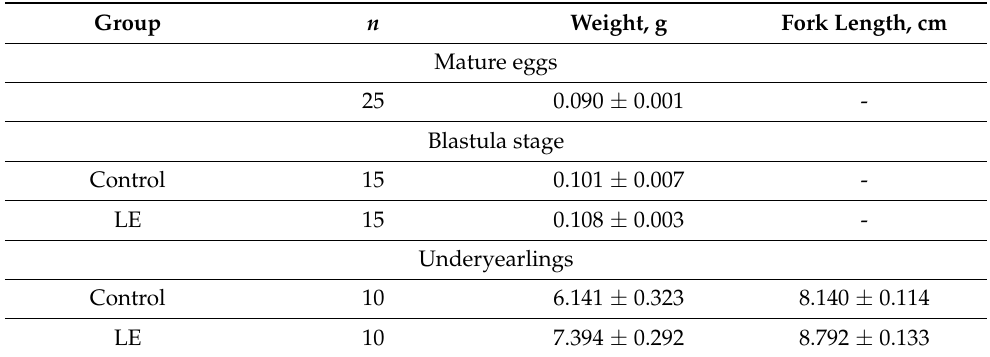
Table 1. Weight and length (M ± SE) characteristics of specimens taken for enzymes activity analysis.